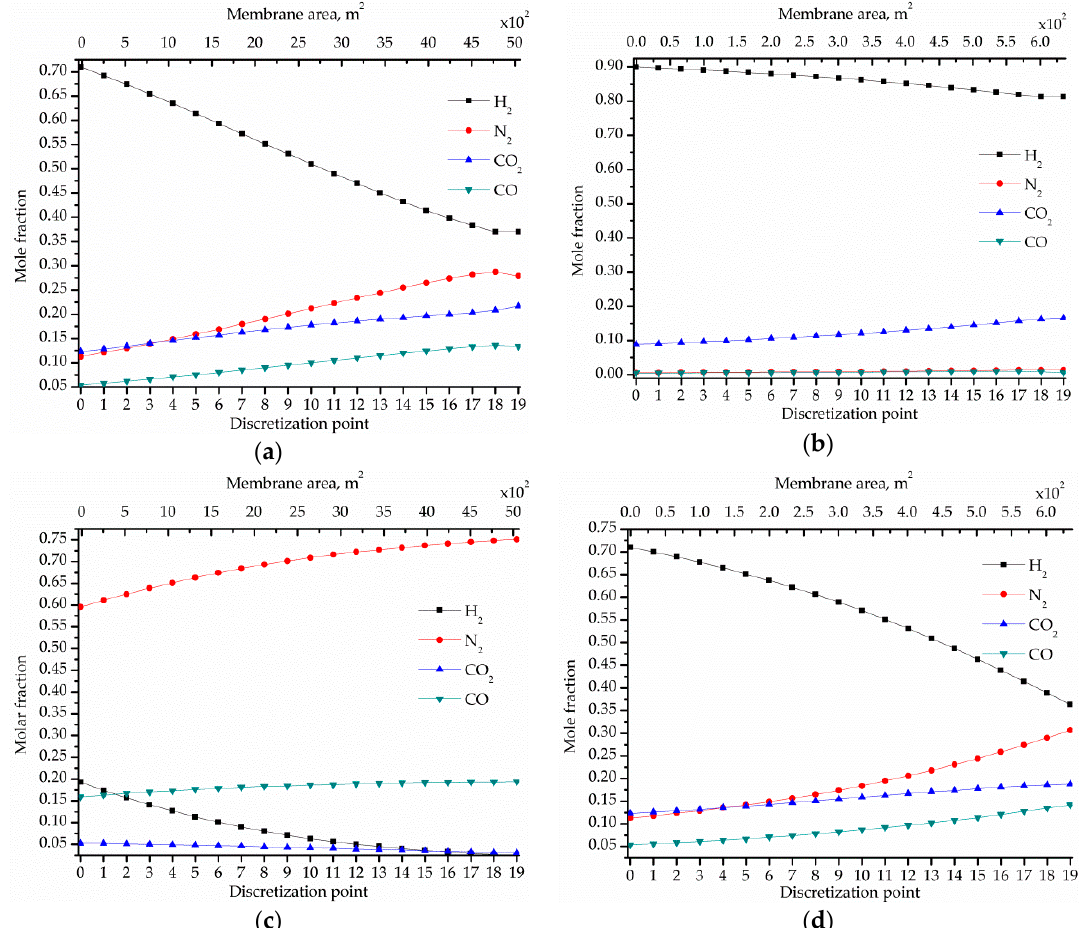
Figure 5. Optimal mole fraction profiles of the components in the membrane modules obtained in solution OPT, in which the driving force for permeation is created by combining compression and vacuum and no expander is included for power recovery: ( a ) Permeate in MS1; ( b ) Permeate in MS2; ( c ) Retentate in MS1; ( d ) Retentate in MS2.